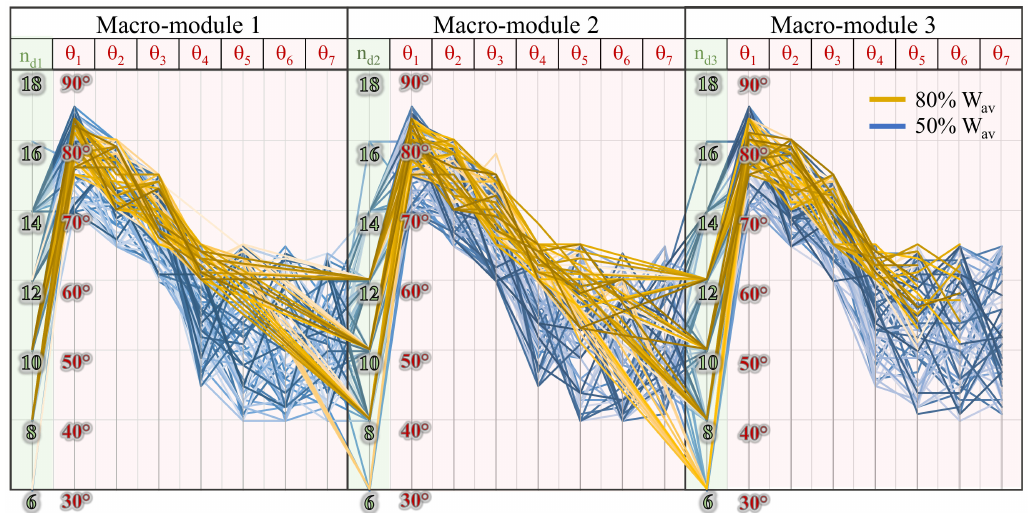
Figure 11. Generative design: parallel coordinates plot for H/B = 6.6: solutions characterised by weight less than 80% and 50% of the average